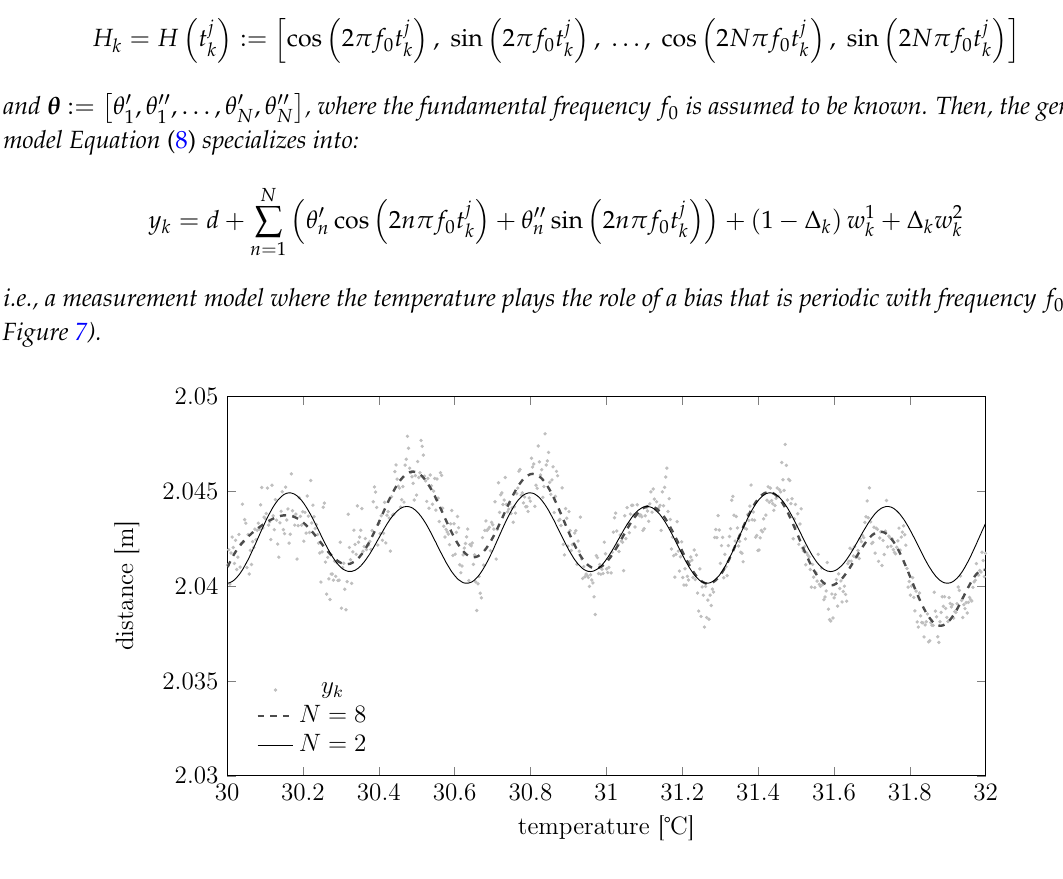
Figure 7. Potential temperature-bias dependencies for the Fourier expansion model of Example